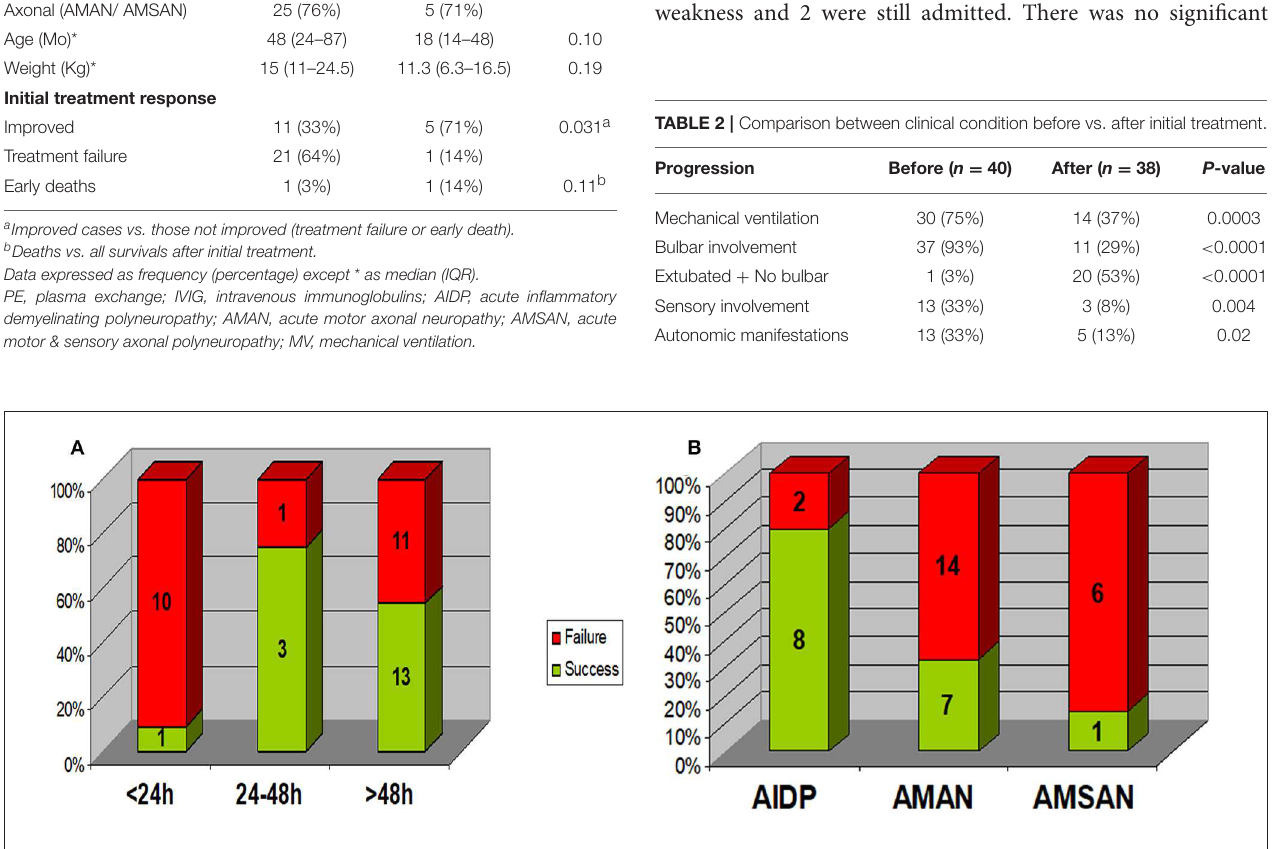
FIGURE 1 | Relation between response to initial treatment and (A) disease progression rate (duration of progression) (B) EMG pattern. Rapid progression within 24h was associated with a lower rate of success of initial treatment (1/11 vs. 16/28; p = 0.003). Those with AIDP had a higher rate of success of initial treatment (8/10) compared to axonal types (8/28); p = 0.02. AIDP, acute inflammatory demyelinating polyneuropathy; AMAN, acute motor axonal neuropathy; AMSAN, acute motor & sensory axonal neuropathy.